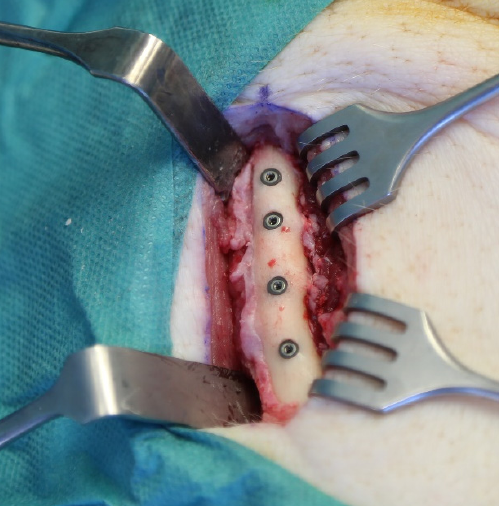
Figure 2. Placement of the implants into the basis of the corpus mandible in the cranial direction.